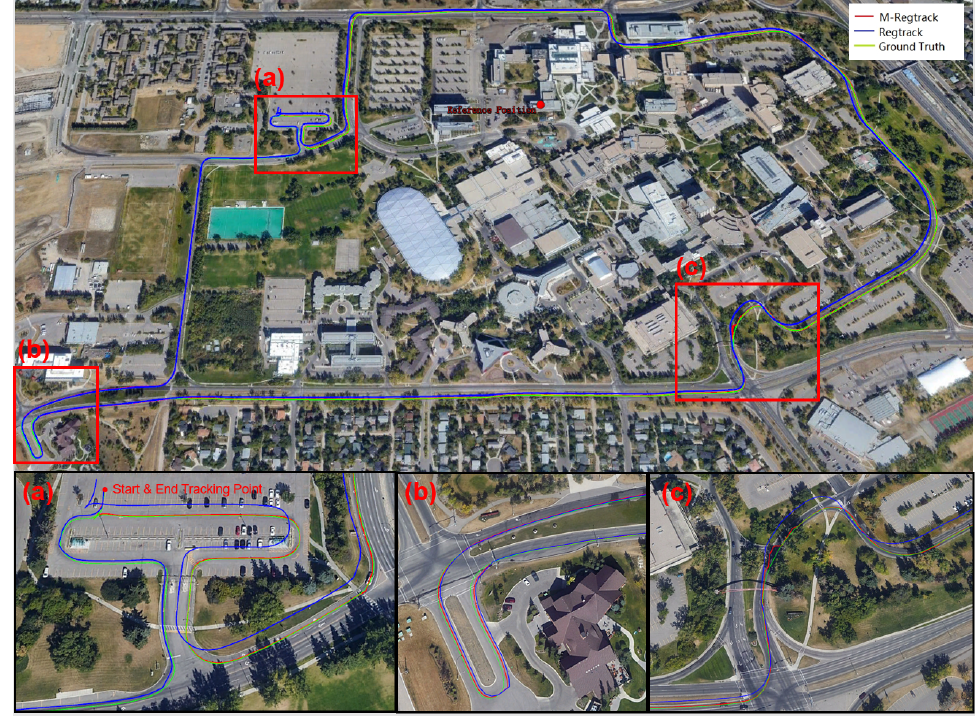
Figure 13. The ground truth map and the tracking result comparison of different methods for the moving car experiment Section 3.2.3, where the red dot was the reference receiver, the ( a – c ) indicate the enlarged